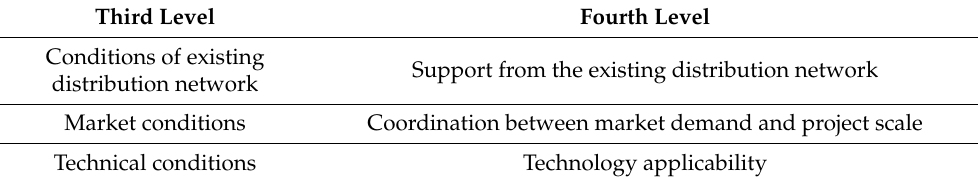
Table 2. Conditions and sub-conditions of feasibility.